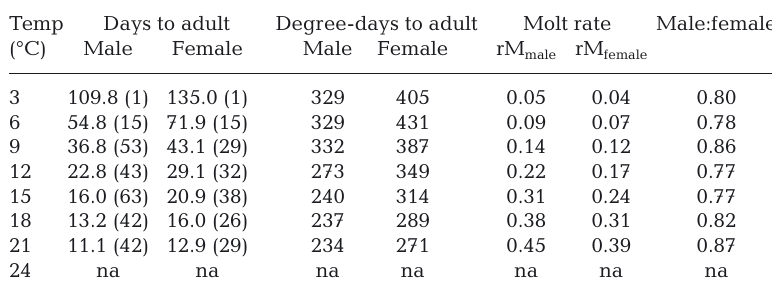
Table 2. Time until the first sampling point at which the majority ( ³ 85%) of Lepeo - phtheirus salmonis males and females were adults. The total number of males and fe- males in the respective samples is given in brackets. Average daily molt rate (rM) = 5/days to adult; male:female = rM male :rM female ; na: not